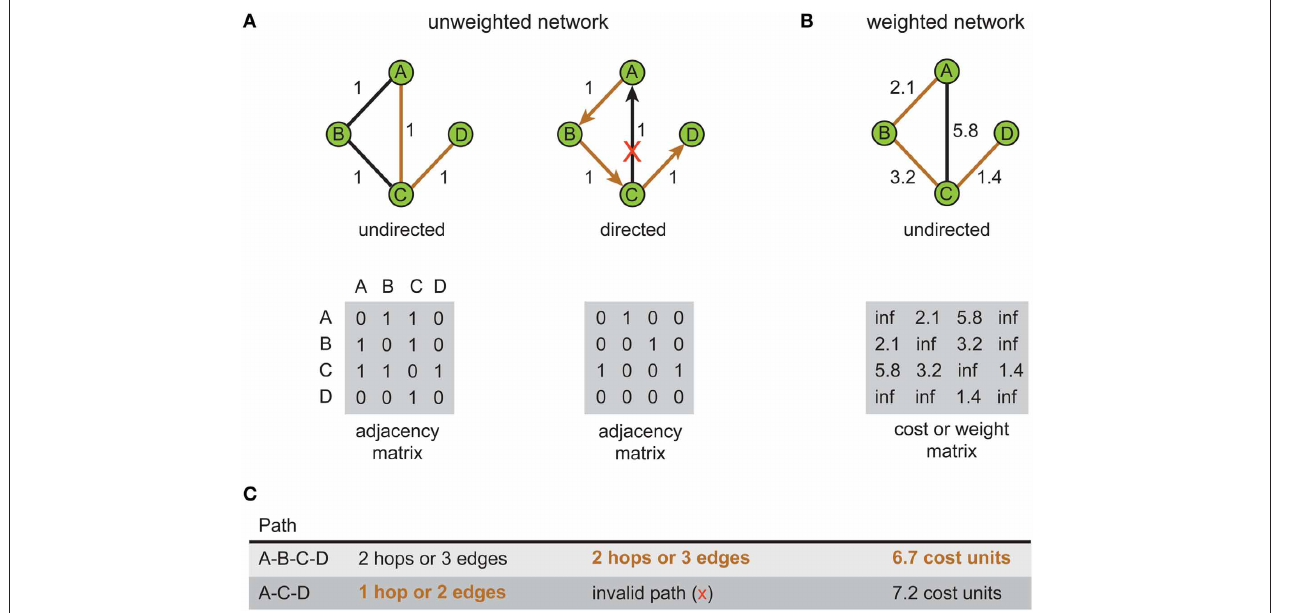
creates an invalid path from vertex A to vertex D. (B) Weighted network representation. Graphical representation (top) of an undirected weighted graph with values of weights (distance) shown next to edges and recorded in the cost or weight matrix below (bottom). Note in the cost or weight matrix the absence of an edge is recorded as an infinite cost (“inf”) while in adjacency matrix it is recorded as zero. (C) Summary table for path length results corresponding to each type of network. Shortest paths are shown in bold brown